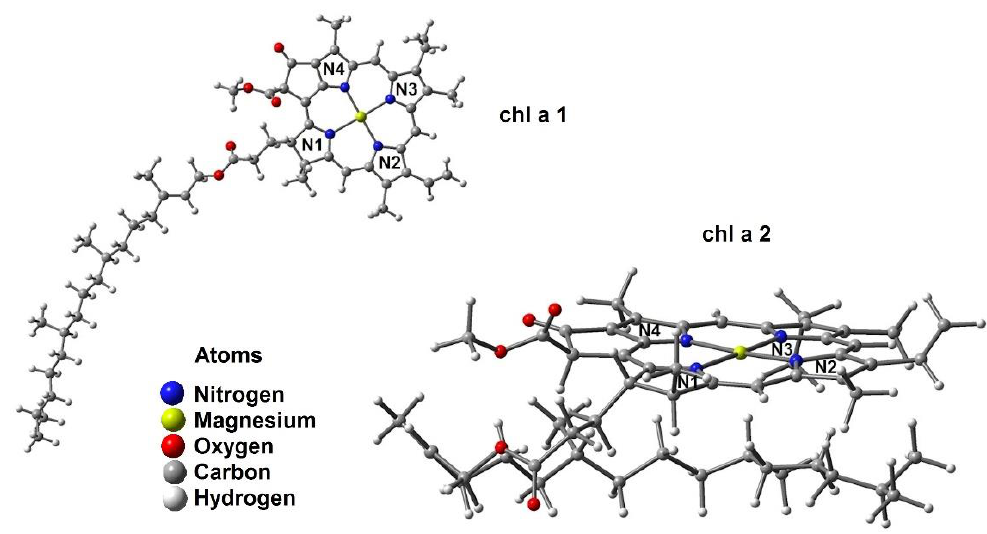
Figure 2. Optimized geometry of the more stable conformers: chl a 1 and chl a 2 . AFB 1 , the most stable conformer, displayed an energy value of − 1106.22 Hartrees. In general, the molecule is planar, but with the A ring perpendicular to the plane.